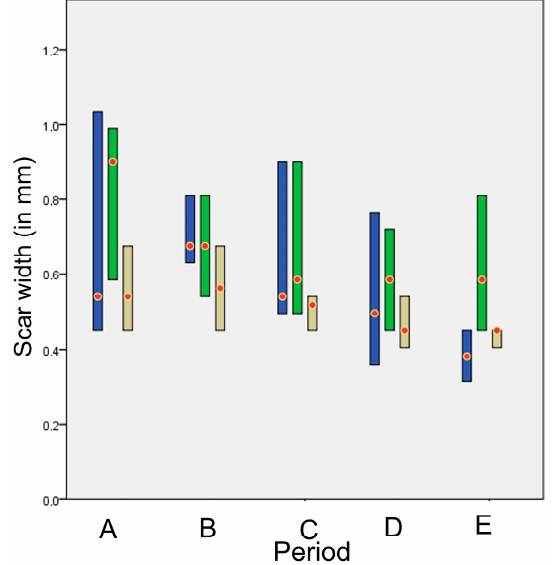
Figure 16. Histologically estimated median (red dot) and interquartile range (column) of the scar width (in mm) for each technique (blue: staples, green: glue, gray: intradermal) in each period [pe-riod A: 1-8 po.d.; period Β : 9-21 po.d.; period C: 22–63 po.d.; pe-riod D: 64–180 po.d.; period E: 181–365 po. d]. No statistically significant difference was observed between the techniques (all p > 0.043).